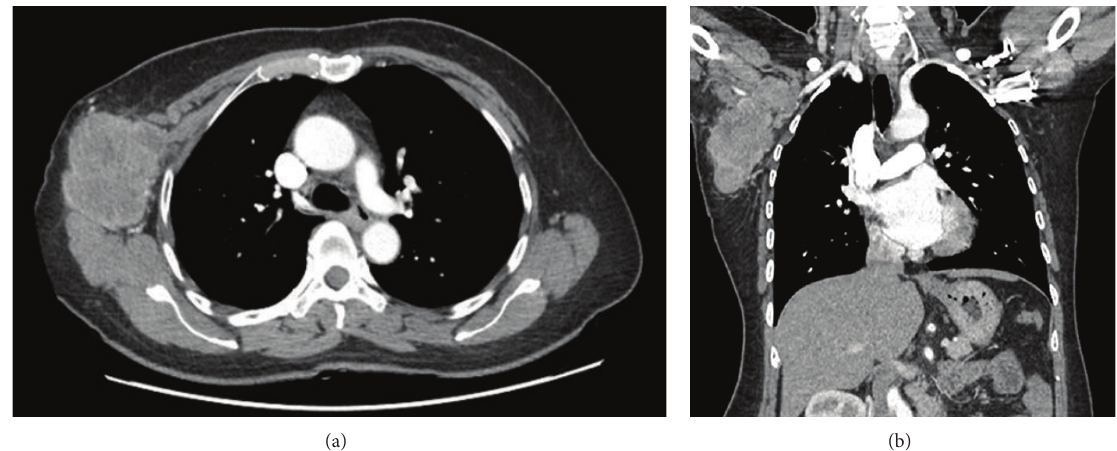
Figure 2: Axial (a) and coronal (b) chest computed tomography images show a 12cm mass with a lobulated contour and heterogeneous enhancement in the right